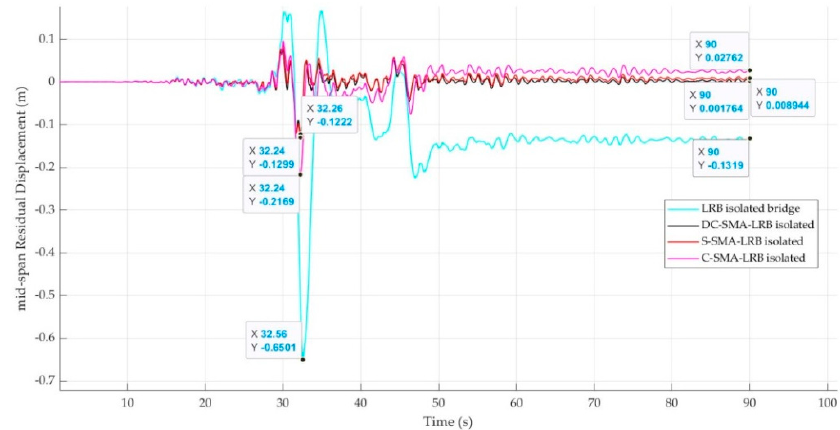
Figure 17. Time history curves of the mid-span displacement under synthetic#3 of the RSN8060 record.